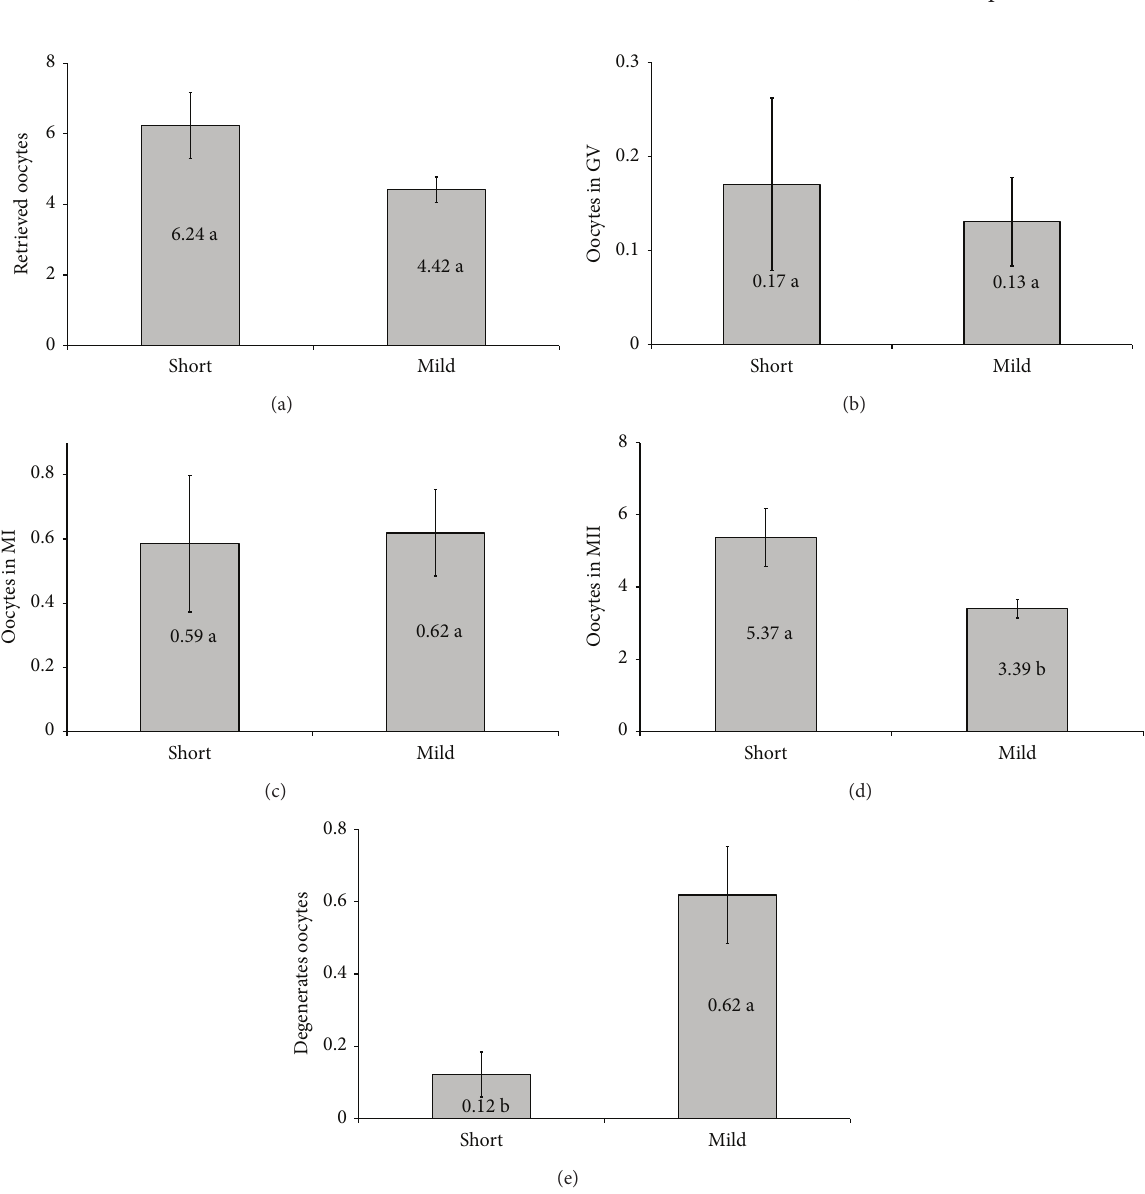
Figure 4: Average number of oocytes per cycle: (a) average of oocytes retrieved, (b) stage of oocytes retrieved at the germinal vesicle (GV), (c) retrieved oocytes in metaphase I (MI), (d) in metaphase II oocytes retrieved (MII), and (e) degenerates oocytes. Means followed by the same letter do not differ significantly by 𝑡 -test at 5%